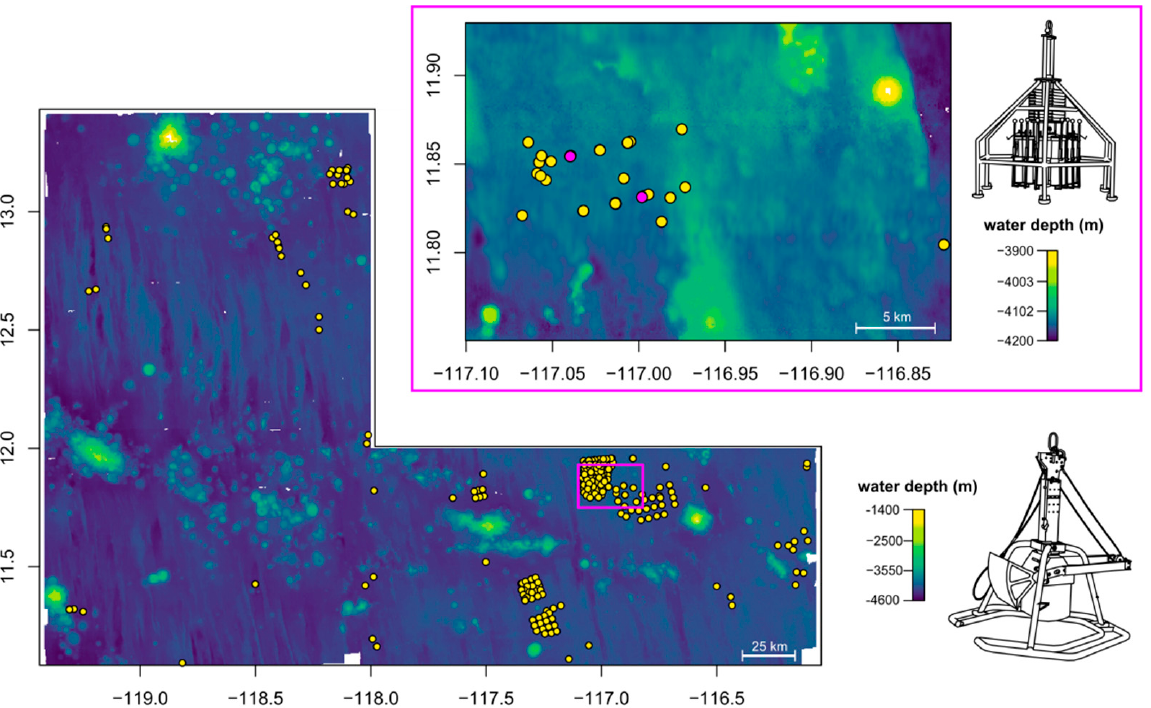
Figure 1. Bathymetric map of the German license area for the exploration of polymetallic nodules with the study area (magenta square) located in the eastern part of the area; points indicate sampling positions of boxcorer deployments ( bottom left ) and detailed bathymetric map of the study area; points indicate sampling positions of multicorer deployments ( top right ). Two time-series stations that were sampled in four different years (2013, 2014, 2016 and 2018) are marked in magenta.